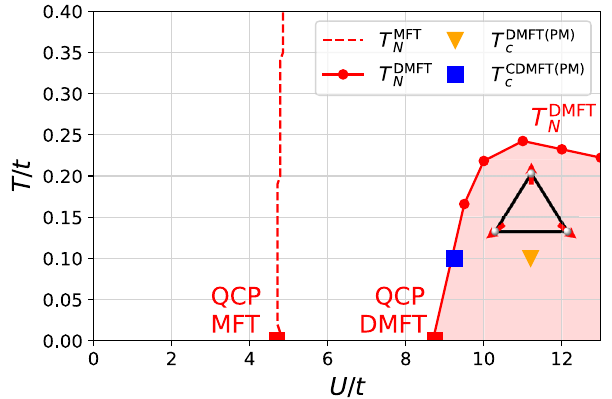
13. Magnetic phase diagram of the isotropic triangular Hubbard model calculated by MFT (red dashed line) and DMFT (red circles and solid line). The red lines mark the second-order transition from a paramagnet (white) to a 120° N´eel ordered phase (red shaded). Also shown are the critical temperatures and interactions of the (PM-restricted) DMFT (orange triangle) and CDMFT (blue square). Note that the CDMFT solution has been restricted to its paramagnetic phase. The DMFT zero temperature point has been taken from the ground state calculation of Ref.